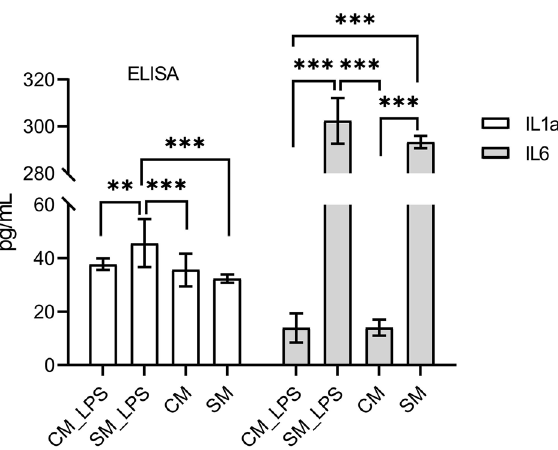
Figure 6. Secretion of cytokines by LESC to the culture medium in all examined groups (CM, SM, CM_LPS, SM_LPS) measured by ELISA. ANOVA with the Tukey post hoc test, **p < 0.01, ***p <